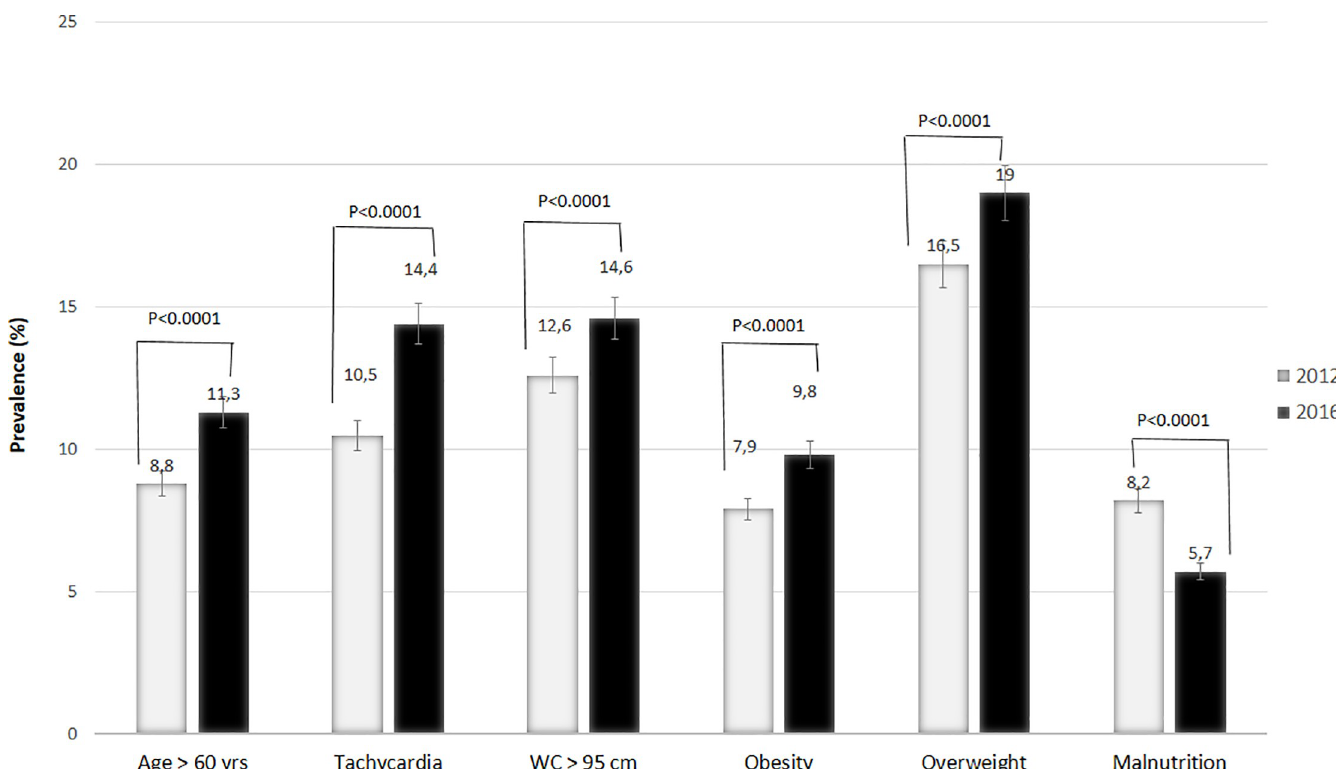
Fig 2. Distribution of cardiovascular risk factors in 2012 and